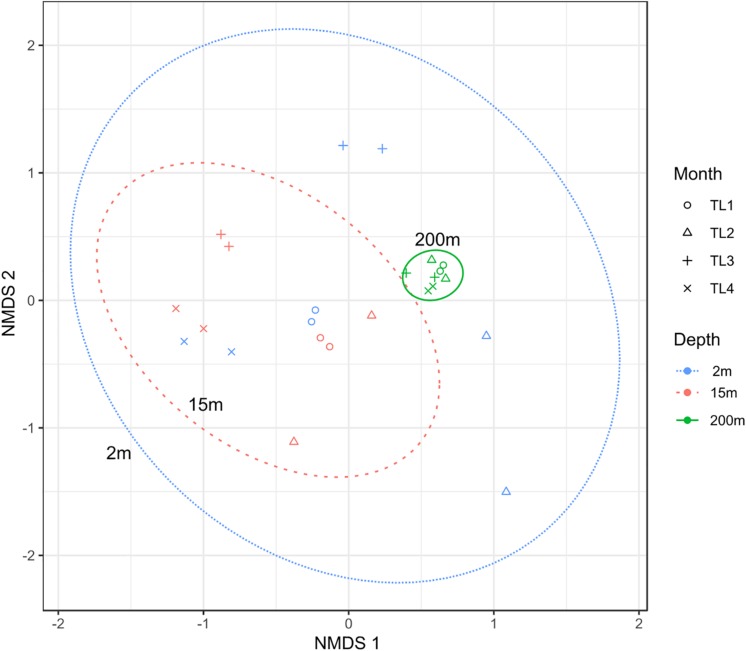
NMDS plot (stress < 0.2) for pt4-SHL2 site showing that depth and month variables are responsible for the community dissimilarities.